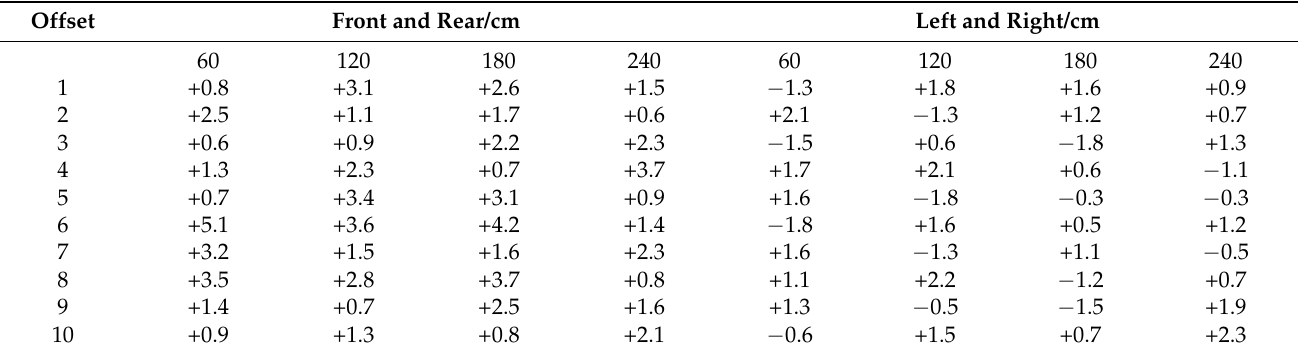
Table 3. Deviations of the